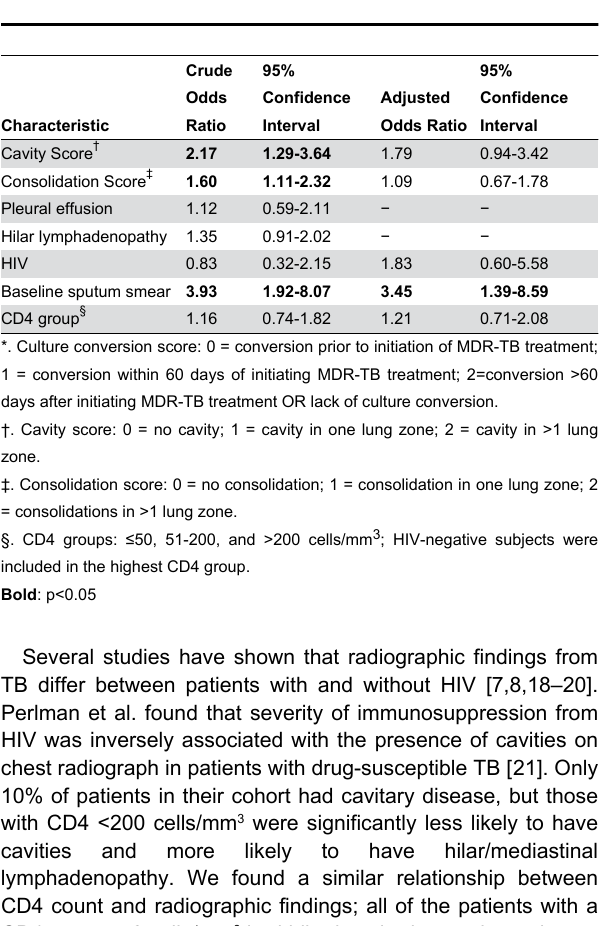
Table 4. Association of radiographic findings and clinical characteristics with culture conversion score * using log- linear